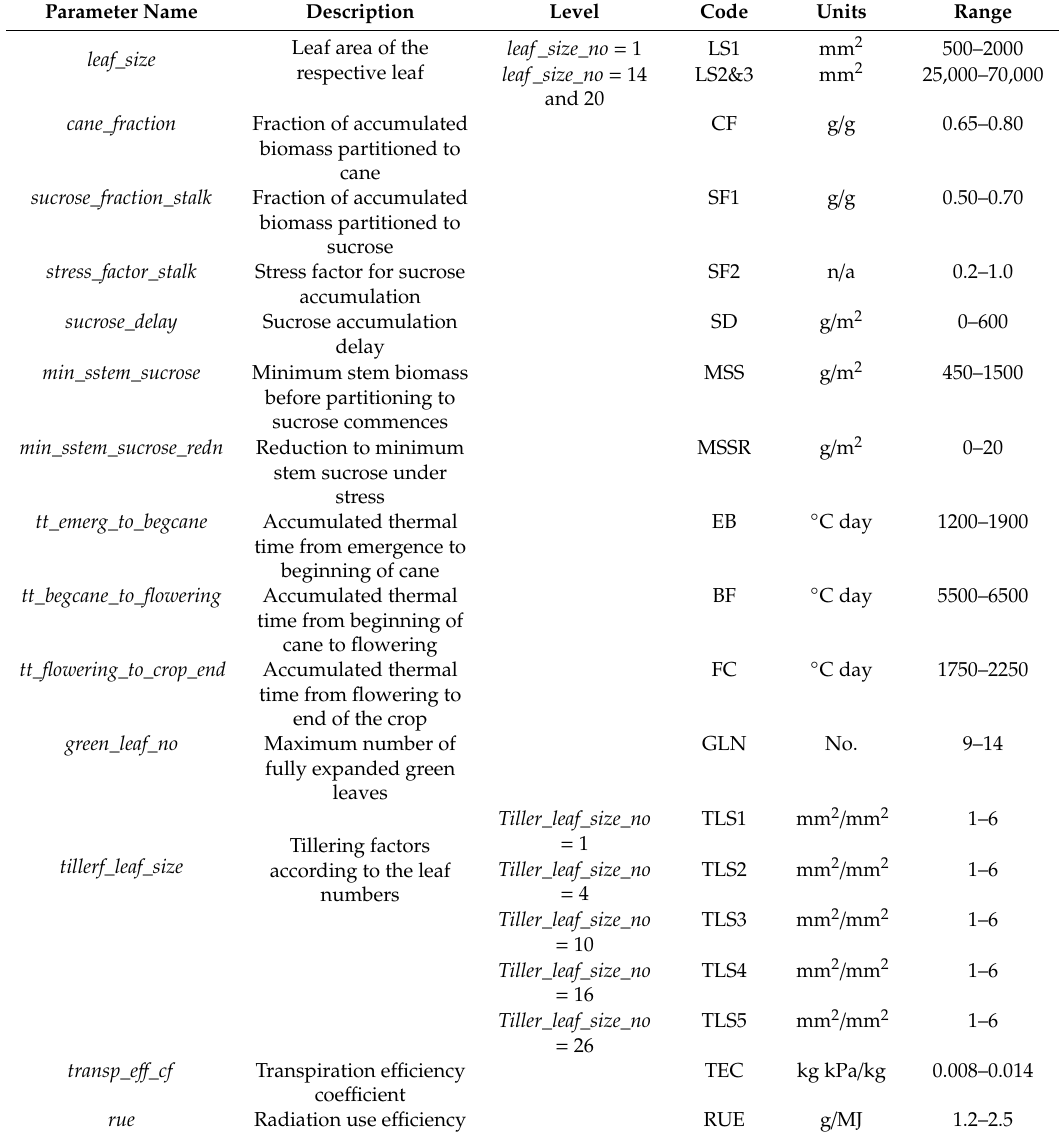
Table 3. Description of the trait parameters and parameter space